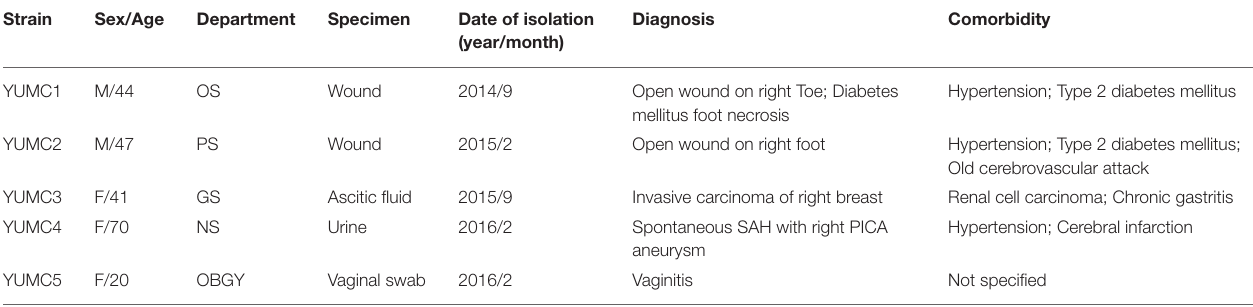
TABLE 2 | Clinical characteristics of the patients infected with IMP-4-producing E. cloacae isolates.